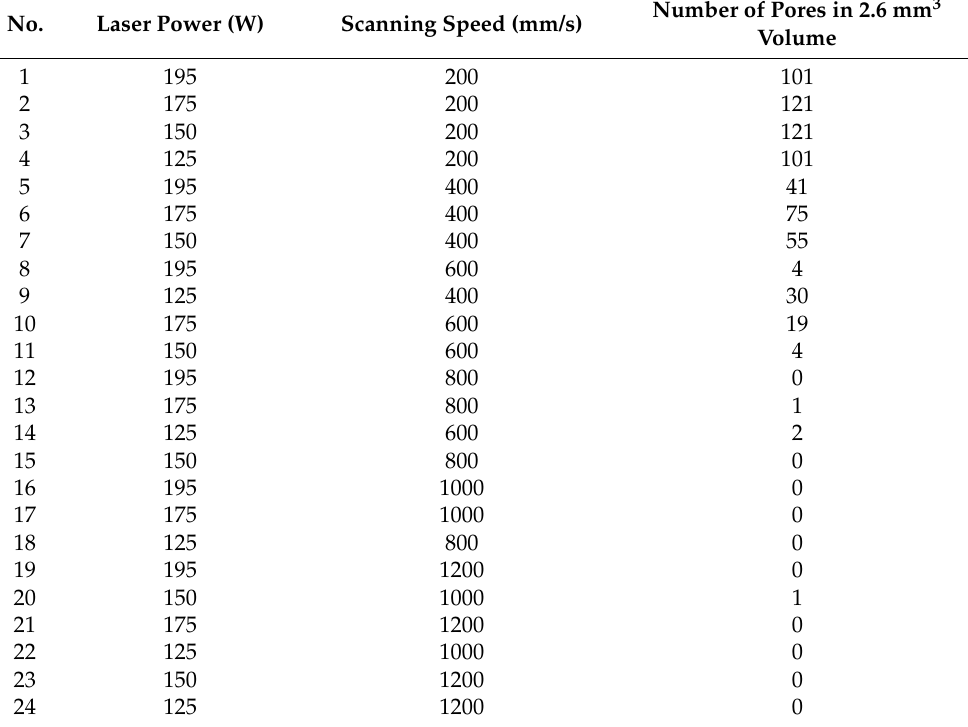
Table 2. Number of pores for each laser power and scanning speed combination [6].